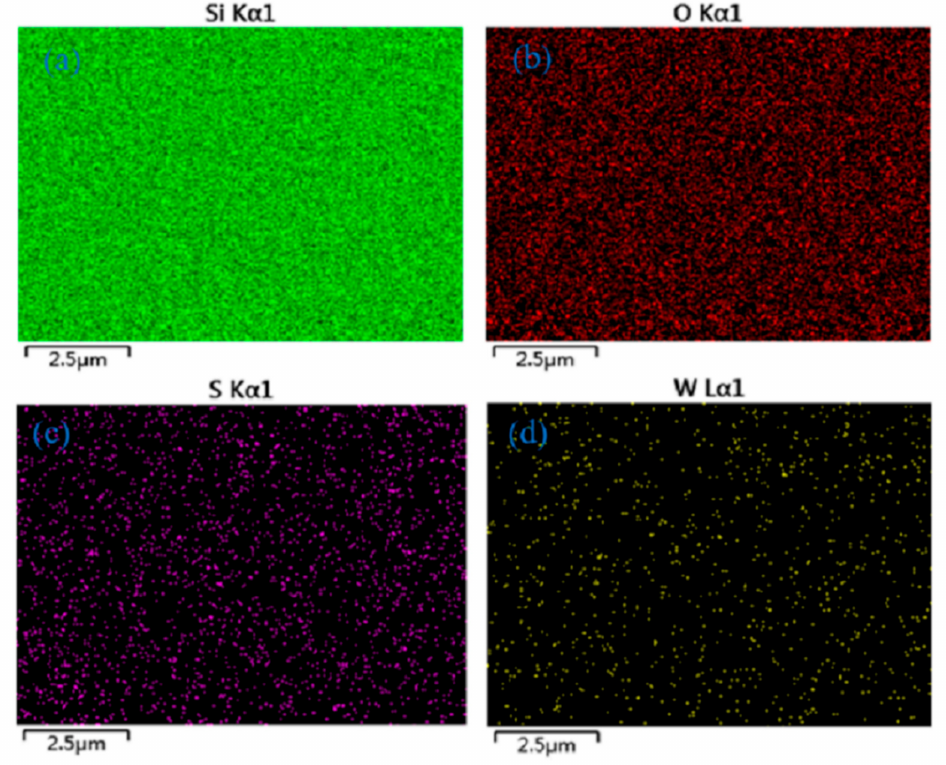
Figure 3. EDS element imaging of WS 2 material on SiO 2 /Si substrate. ( a ) Si, ( b ) O, ( c ) S, ( d )